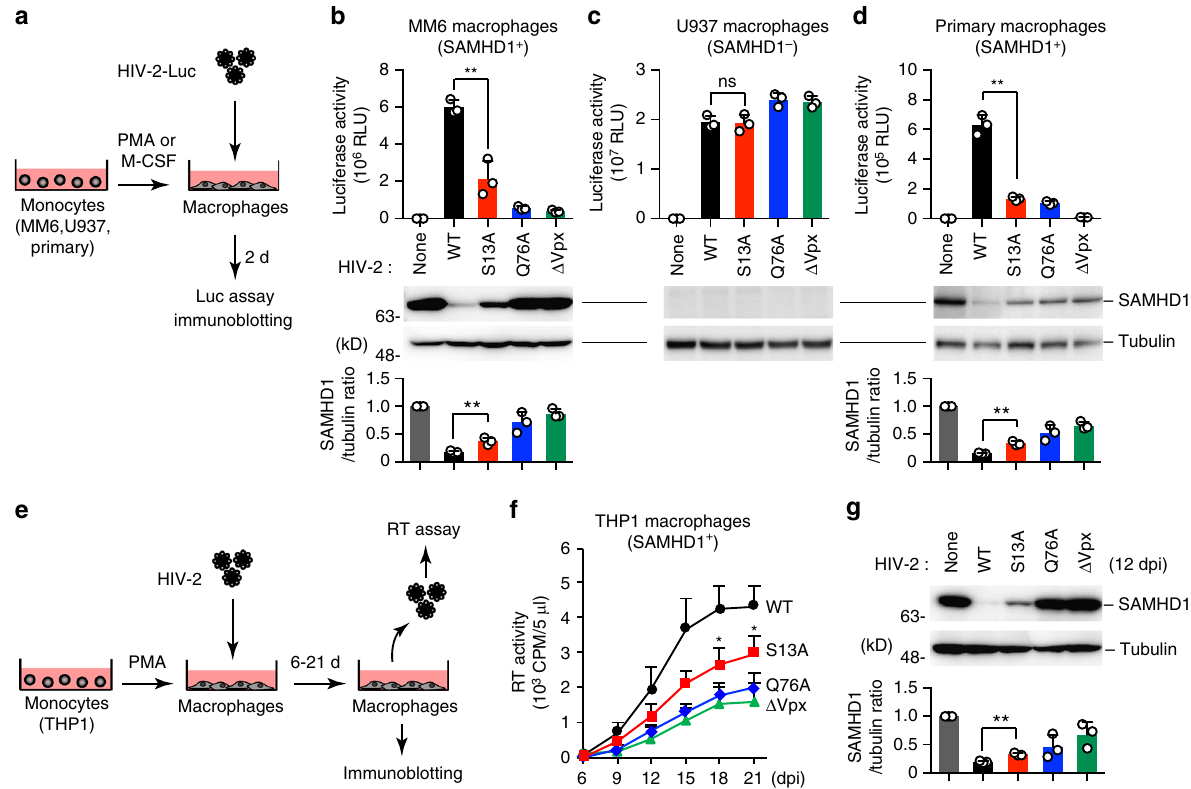
Fig. 3 Low infectivity of HIV-2 bearing Vpx-S13A in myeloid cells. a – d Single-cycle HIV-2 infection assays in various human macrophages. Schematic representation of the experimental design ( a ). Brie fl y, monocytic cells were differentiated into macrophages by PMA or M-CSF and then infected with the indicated HIV-2 encoding luciferase (Luc) reporter gene. Forty-eight hours after infection, intracellular luciferase activity was measured for Monomac6 (MM6) ( b ), U937 ( c ) and primary monocyte-derived macrophage ( d ). Endogenous SAMHD1 expression in infected cells is also shown. Bar charts below the blot indicate the ratio of SAMHD1 over Tubulin, as determined by densitometry. e , f Multi-cycle HIV-2 replication kinetics in THP1-derived macrophages. Schematic representation of the experimental procedure ( e ). Cells were infected with wild-type HIV-2 GL-AN and its Vpx-S13A, Q76A, and Vpx-de fi cient mutants. RT activity of each supernatant was measured at the indicated time points ( f ). g SAMHD1 expression in the indicated HIV- 2 – infected THP1-macrophages, 12 days after infection. Bar chart below the blot indicates the ratio of SAMHD1 over Tubulin, as determined by densitometry.All graphs are presented as a mean ± s.d. ( n = 3). * P < 0.05; ** P < 0.01; ns, not signi fi cant, two-tailed unpaired t -test. Source data are